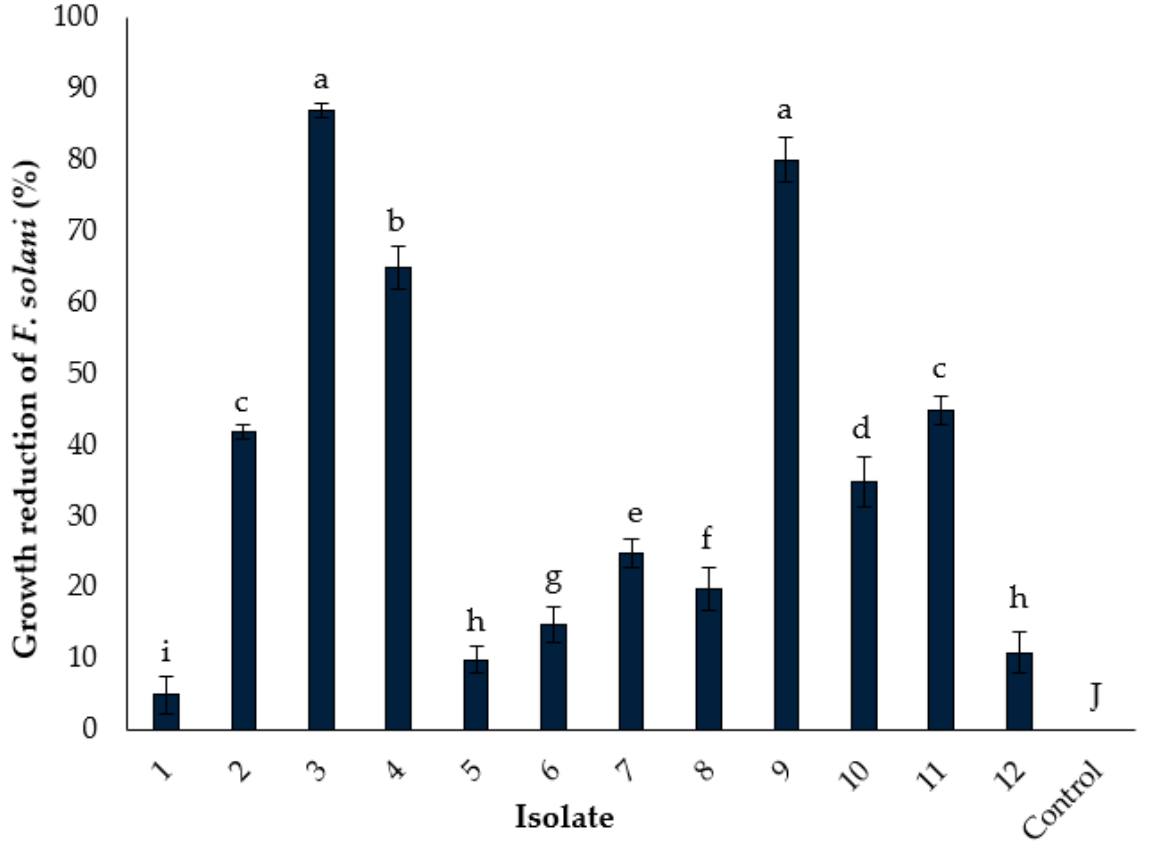
Figure 3. In vitro screening of fungal endophytes for their biocontrol potential against the highly virulent Fusarium solani isolate. Identical letters within each treatment are not significantly different at the p < 0.05 level of confidence according to the least significant difference (LSD) multiple range test.